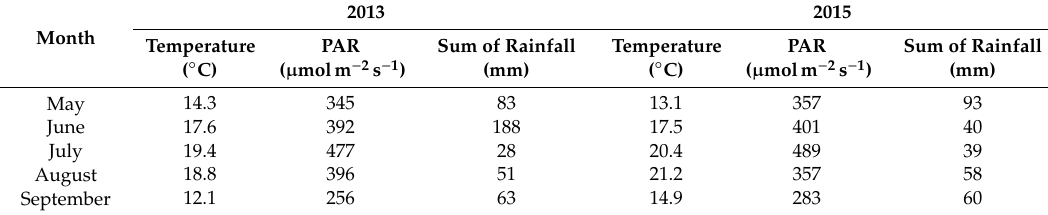
Table 1. Mean monthly temperature, photosynthetically active radiation (PAR) and sum of rainfall in vegetation seasons 2013 and